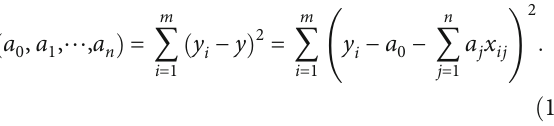
and S members of well 2 3